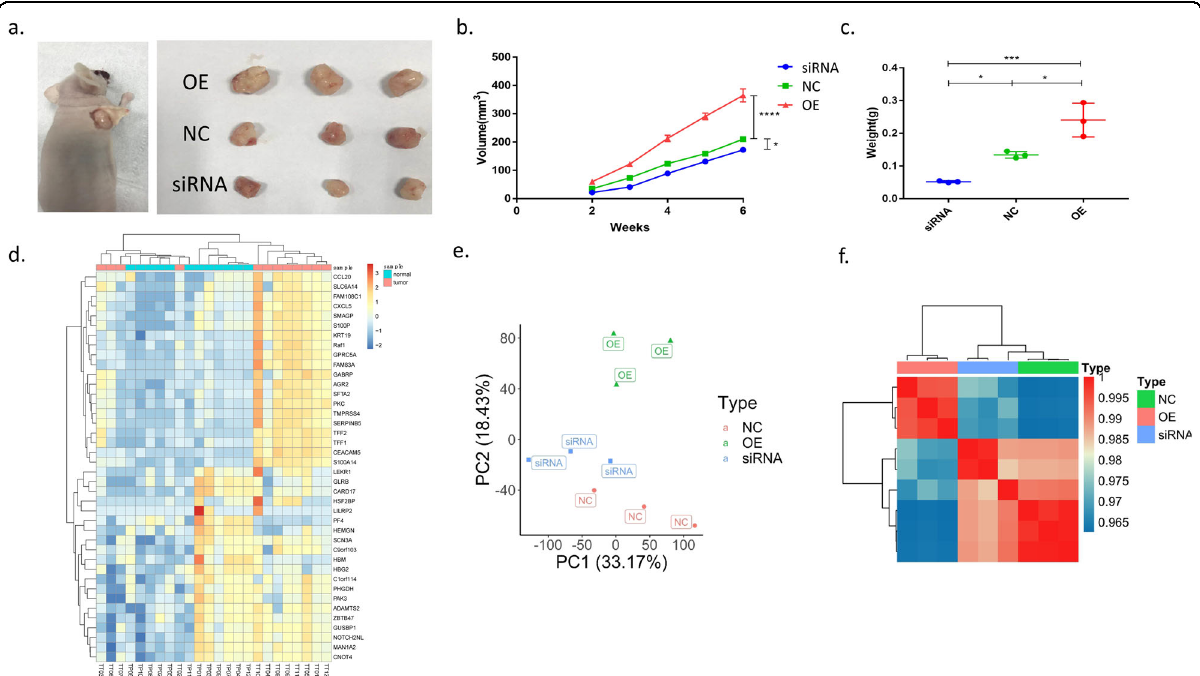
Fig. 4 DEGs analysis in samples from tumor-bearing nude mice models and PA patients. a Tumors of nude mice (3 repeats in each group). b Weekly volume change of nude mice implanted tumors (3 repeats in each group). c Weight change of nude mice implanted tumors after six weeks. (OE: TRPM2 overexpression, NC: normal control, TRPM2 siRNA: TRPM2 interference expression group, * P < 0.05, *** P < 0.001, **** P < 0.0001, 3 repeats in each group). d Heatmap of top 40 differentially expressed genes (DEG) between TT and TP groups of patients ’ PA samples (12 samples each for TT or TP samples). e PCA clustering showed signi fi cant differences among NC, OE, and siRNA groups (3 samples in each group). f Heatmap of DEGs among NC, OE, and siRNA groups (3 samples in each